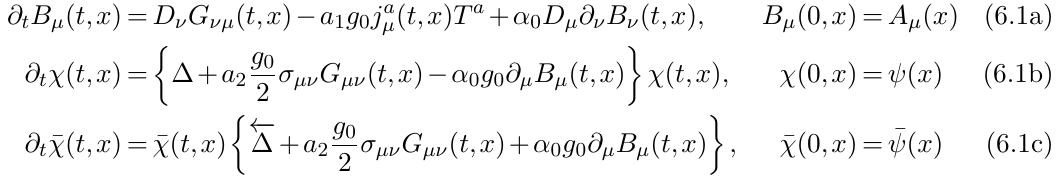
QCD , but the QCD